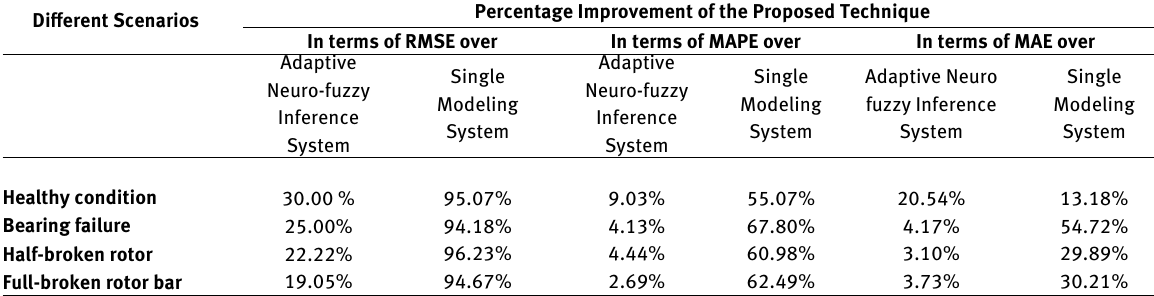
Table 6: Percentage improvement of the proposed technique over existing techniques Different